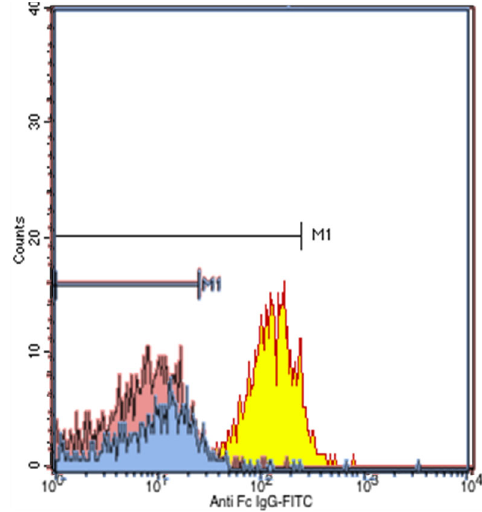
Figure 3. The negative results of the B-lymphocyte flow cytometry examination.